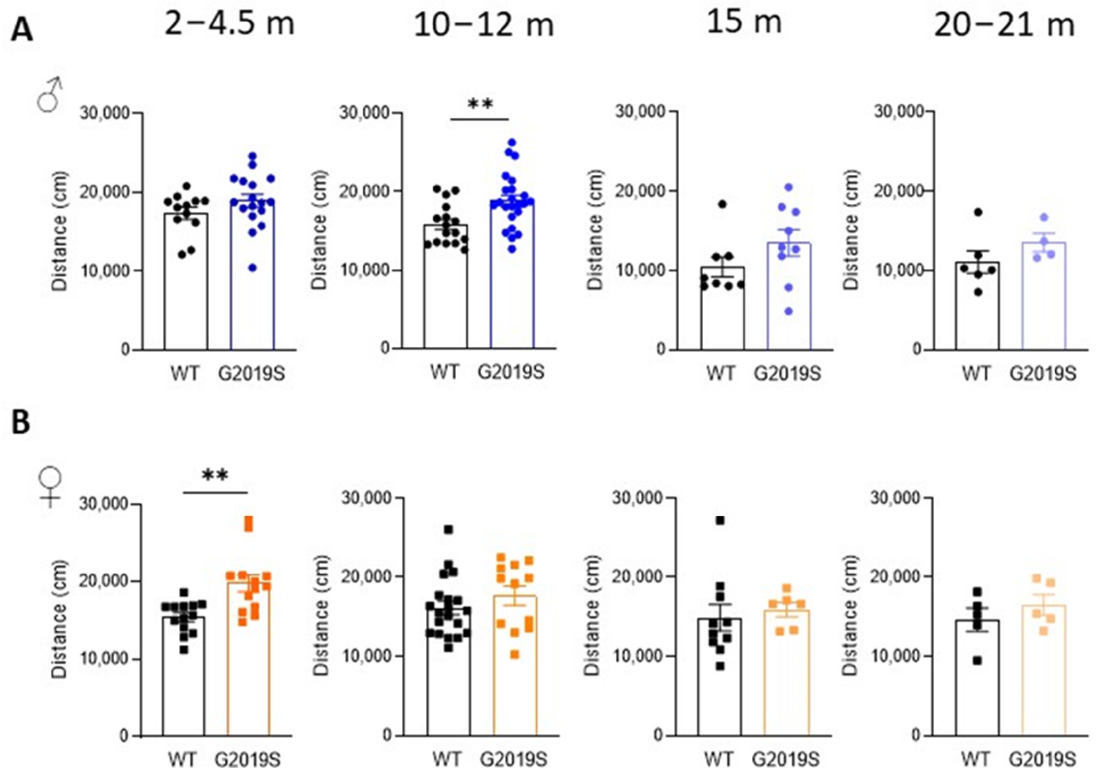
Figure 1. Male and female G2019S mice display hyperlocomotion at different ages. Total distance covered in the open field test during 60 min by male ( A ) and female ( B ) WT and G2019S mice at the ages indicated above the graphs (m: months). N = 4–23 mice in each group. ** p < 0.001 unpaired Student’s t -test. Circles represent data of male. Squares rep- resent data of female. Colors indicate different ages.